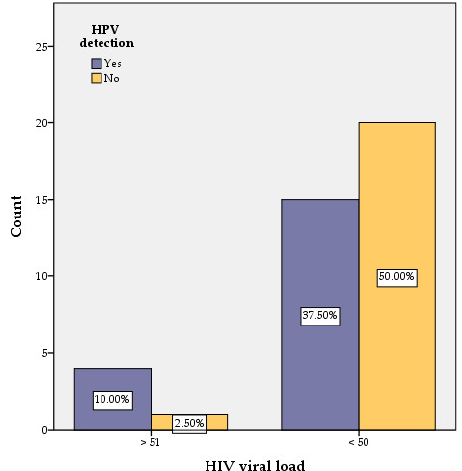
Figure 5. Correlation of HPV with HIV viral load. 3.4. Correlation of HPV with Antiretroviral Therapy and Duration of HIV Detection Analyzing the duration of antiretroviral therapy for HPV-positive and HPV-negative women), we found that the mean duration of therapy for HPV-positive was 12 years, while the mean duration of antiretroviral therapy for the HPV-negative group was 19 years with a statistically significant difference between the two groups ( p < 0.001). The duration of HIV infection for the group of HPV-positive women was between 13 and 27 years, with a median value of 20 years and an interquartile range = 8 years, and the duration of HIV infection for the HPV-negative group was between 6 and 29 years, with a median value of 19 years and an interquartile range = 10.50 years. By comparing the mean values of the duration of HIV infection between the two groups of HPV-positive and HPV-negative women, we found that there are no significant differ- ences between their values ( p > 0.05). 3.5. Correlation of HPV with Sexual Activity (Number of Sexual Partners and Age at First Sexual Intercourse) Number of sexual partners was an important factor for the detection of HR-HPV types . Women with two or more previous sex partners were predisposed to HPV infec- tion. The risk of having HPV was greater than 4.13 times in the group of women with more than two sexual partners, compared to the group of women with one or two sexual partners. These differences have statistical significance ( p < 0.05). The younger the age when sexual life begins, the higher the risk of being detected with HPV types. Fourteen of the 19 women with detectable HPV types began their sexual life before the age of 18. Only 8 of the 21 patients with undetectable HPV types started having sex before the age of 18. The risk that a woman who began her sexual life before the age of 18 would develop an HPV infection was 4.55 times higher compared to women who began asexual life after 18 years old. The differences between the two groups of pa- tients have statistical significance ( p < 0.05). 3.6. Correlation of HPV with Cytobacteriological Results Vaginal discharge did not influence the detection of HPV in HIV-positive women but the identification of Candida in vaginal discharge presented a5.4 times higher risk of having an HPV infection than the women without Candida ( p < 0.05). The same situation was noticed in the case of Gardnerella infection, which was also associated with a five times higher risk of having HPV than the group of women without Gardnerella ( p < 0.05).